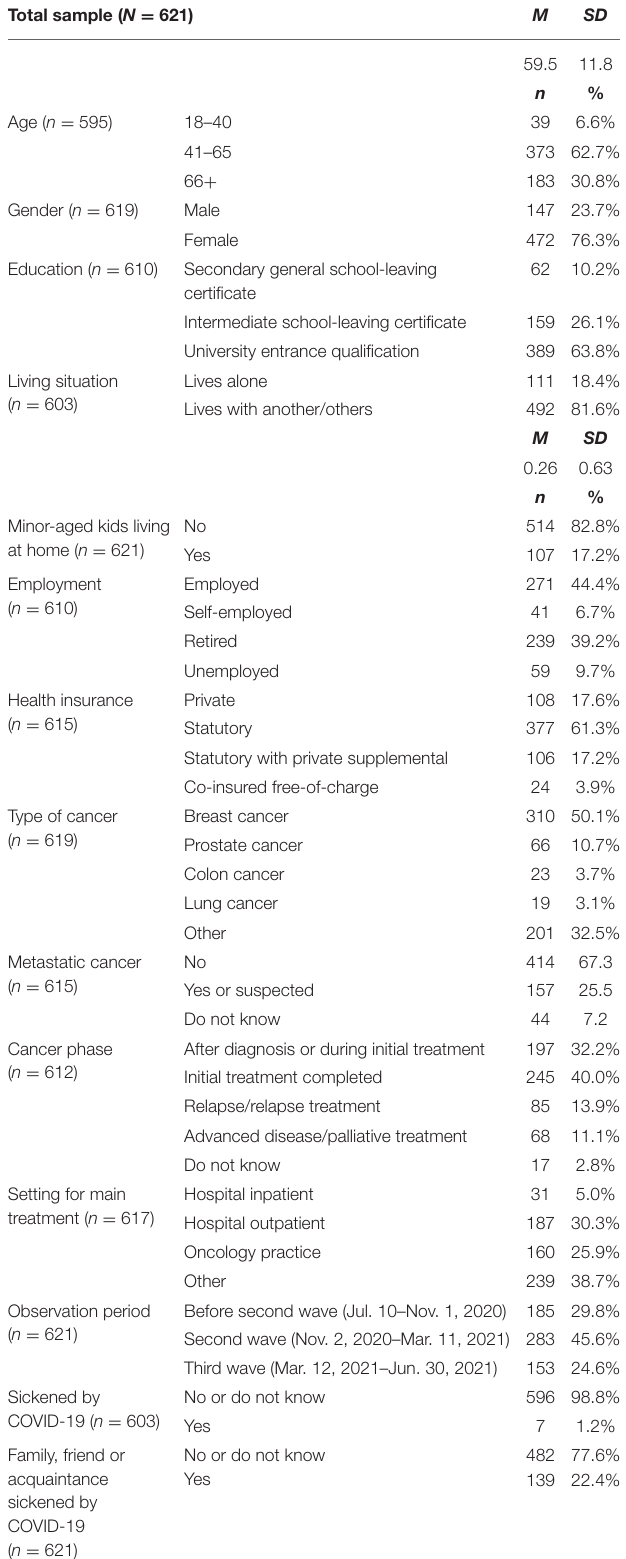
TABLE 1 | Patient demographic characteristics and clinical